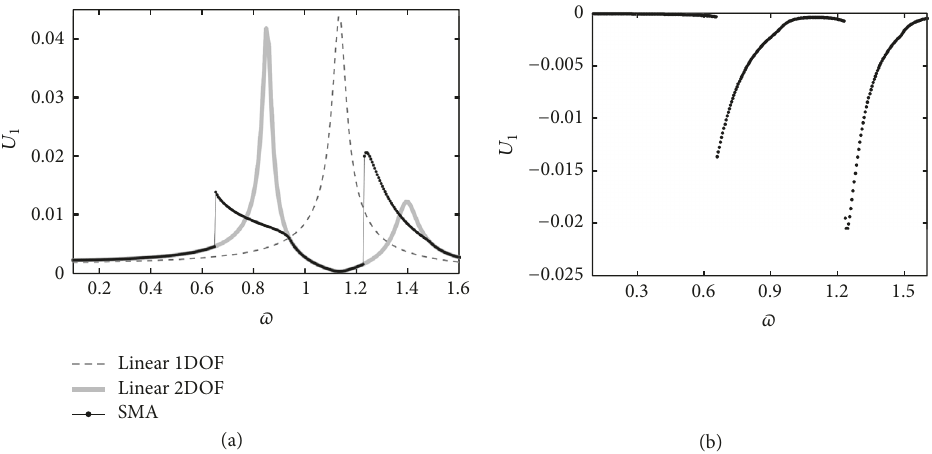
Figure 7: Primary system response with 𝛿 = 0.0025 and 𝛾 𝑚 = 0.22 in down-sweep test: (a) maximum amplitude; (b) bifurcation